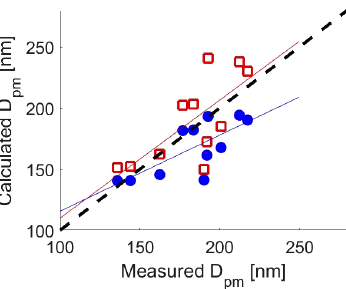
y = 0 . 57 + 0 . 77 and R 2 = 0 . 468 for σ( d M/ d x d z ). Thus, both parameterizations do not predict modal width as well as D pm